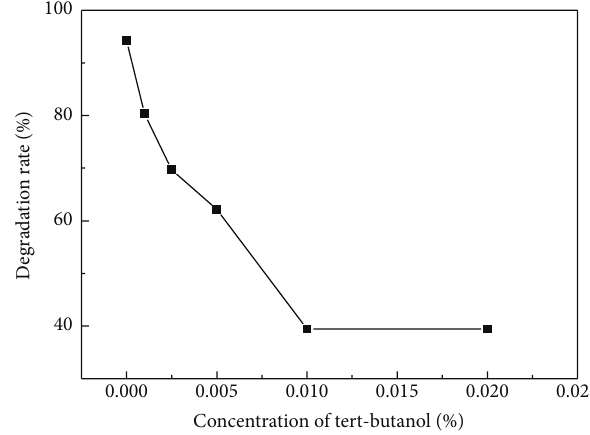
Figure 11: The degradation rate of phenol with different concentra- tion of tert-butanol added in the electrocatalytic